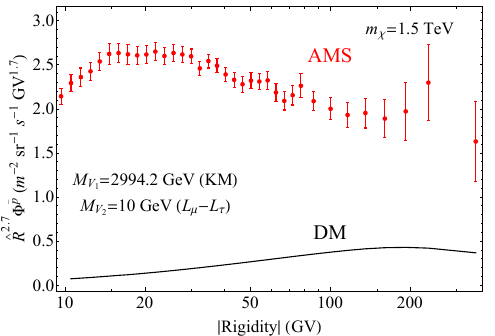
Figure 12 . AMS antiproton spectrum as a function of rigidity. The red points are AMS antiproton data [63]. The black curve is the predicted antiproton (cid:13)ux from the DM models, where we take into account both annihilations from the MW halo and from the nearby subhalo. The subhalo pro(cid:12)le and the DM model are the same as (cid:12)gure 4. The rigidity R is related to the kinetic energy T via q T = R 2 + m 2 (cid:0) m p p